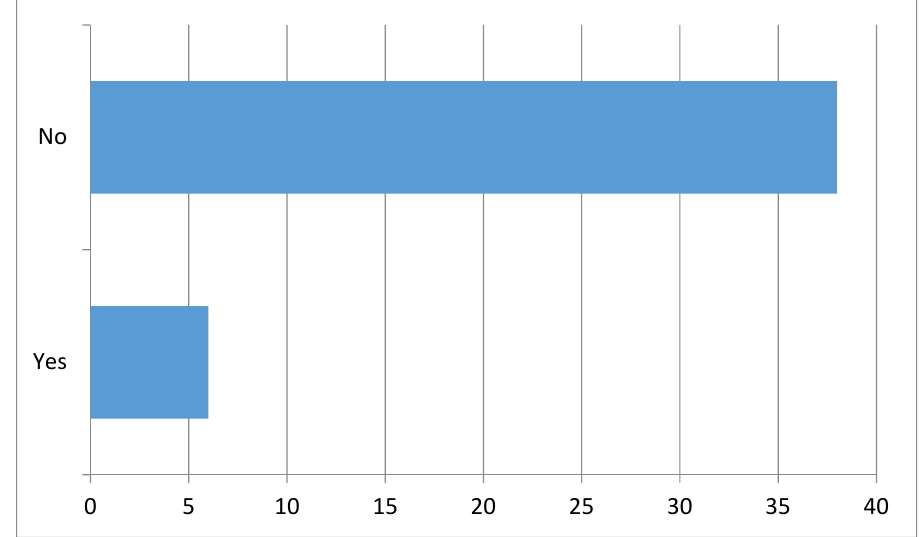
Figure 9. Experience Publishing in OA